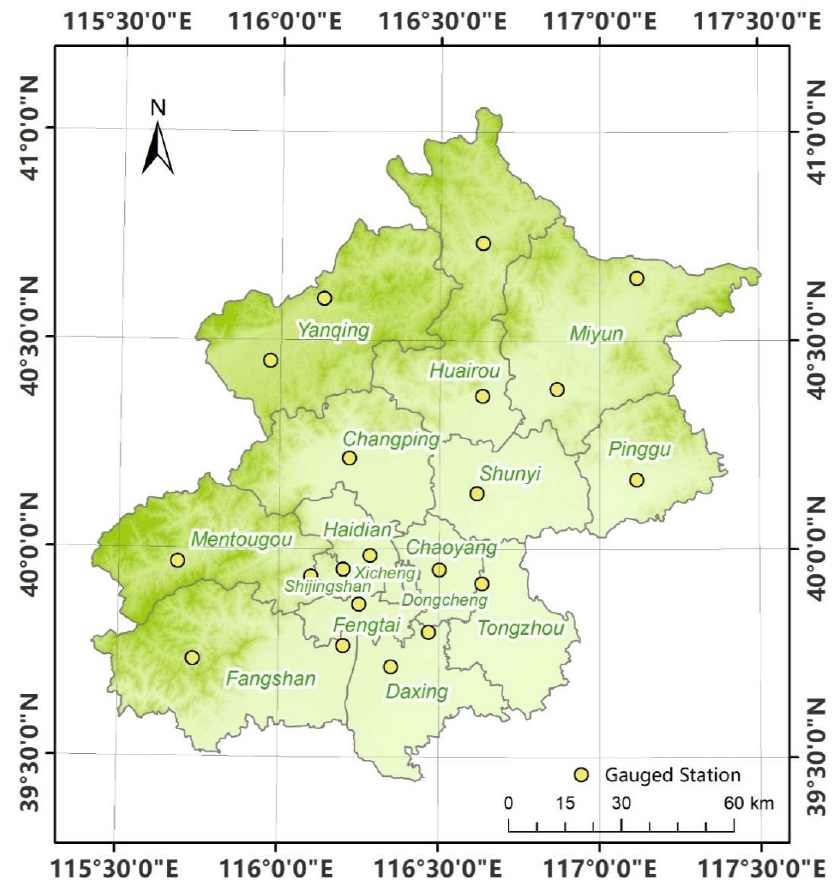
Figure 1. The location of 20 rain-gauged stations.